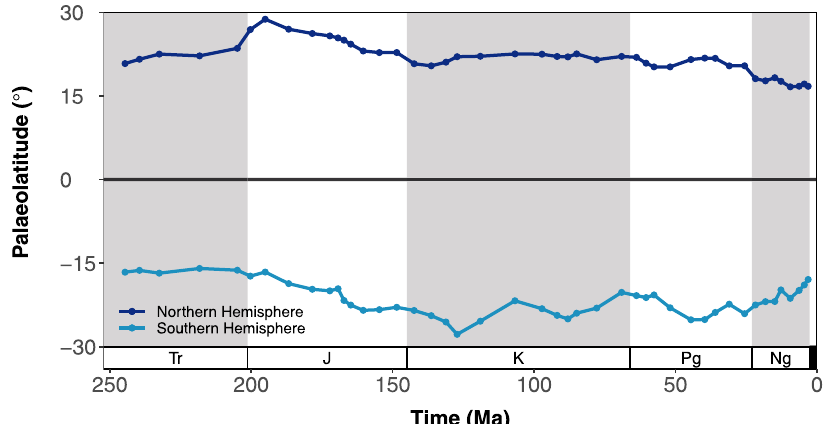
Fig. 3 Palaeolatitudinal shifts in the centroid of suitable habitats for warm-water coral reefs from the Anisian (Triassic) to the Piacenzian (Neogene). The centroid was computed from binary suitability maps under threshold ‘ LTP ’ (least training presence). Centroid calculation was carried out for each hemisphere and implemented with weights proportional to the area of each suitable cell to account for variable cell area with latitude. Period abbreviations are as follows: Triassic (Tr), Jurassic (J), Cretaceous (K), Paleogene (Pg), and Neogene